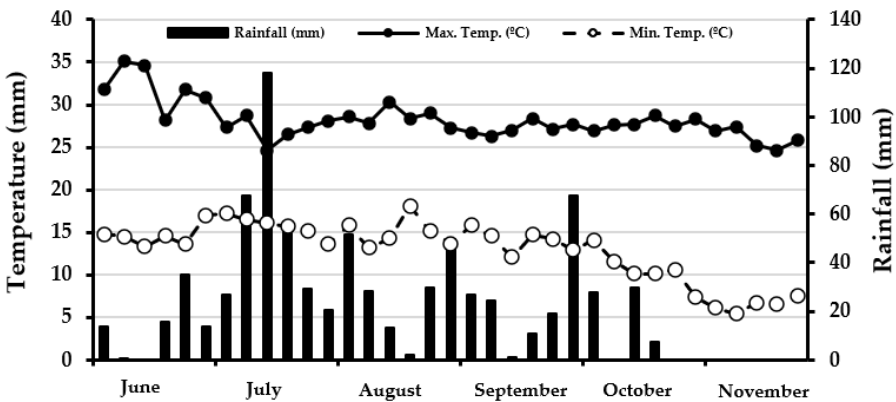
Figure 1. Averages for the maximum and minimum temperatures and accumulated rainfall in five ‐ day periods at INIFAP ‐ CEVAG ‐ Durango, México [28,29].